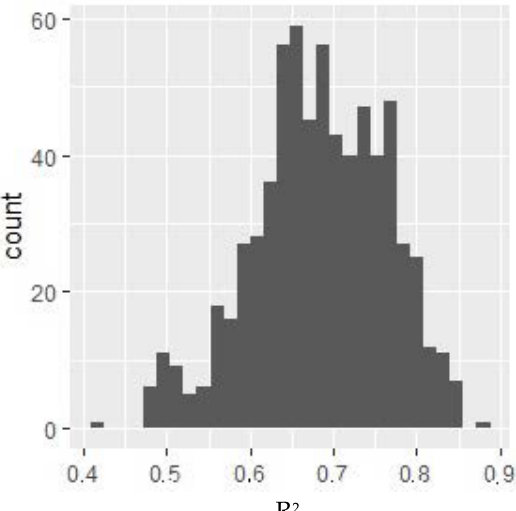
Figure 1. R 2 value histogram for models for VO2 max. Y -axis: the number of models where R 2 of the given value was obtained. The selected model includes the following variables: monocytes %, sodium, and total calcium. All of these parameters negatively affected the relative VO2 max (i.e., as their value increases, the relative VO2 max decreases).